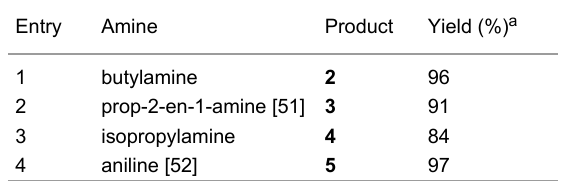
Table 1: Amide coupling reactions of pent-4-ynoic acid with different amines.